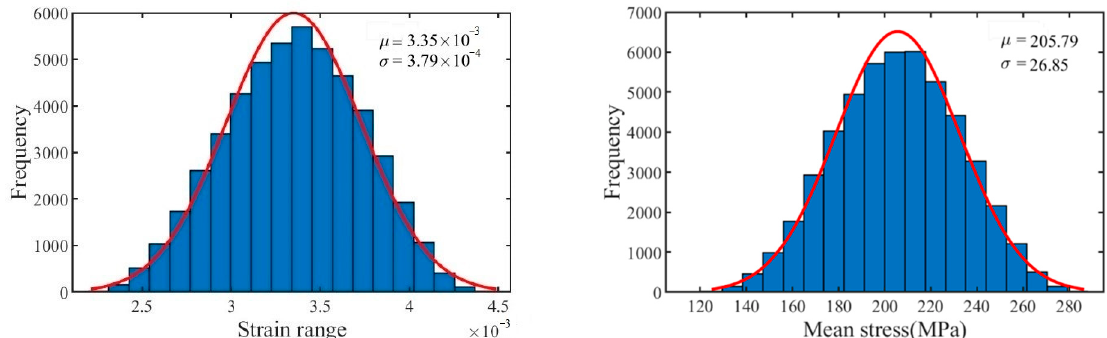
( b ) Figure 8. Comparison between predicted values and simulation values: ( a ) strain range; ( b ) mean stress. According to the calculation of the simulation and prediction data, the RMSE value of the strain range was 3.86 × 10 − 5 and the R 2 value was 0.9601, and the RMSE value of the average stress was 1.96 and the R 2 value is 0.9629, which show that the Kriging model has a high prediction accuracy and can be used to replace the FE model. Regarding calculation time, each FE simulation took about 30 min, while the total prediction time of the Kriging model for these 20 sample points was about 0.04 s, which was greatly reduced compared to the FE simulation. 3.4. MCS and Thermal Fatigue Life Calculation The distribution of uncertain parameters was determined for MCS. According to the operation characteristics of the injection mechanism, both the pouring temperature and the preheating temperature were assumed to follow normal distributions. The pouring temperature of the molten metal ranged from 660 to 720 °C, the preheating temperature